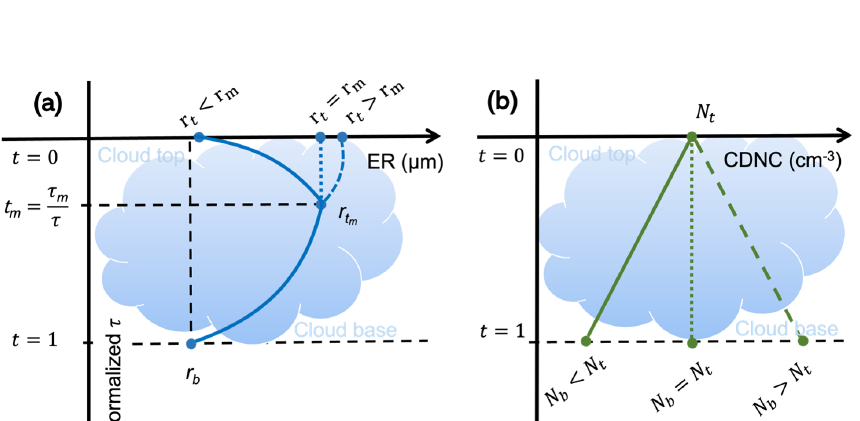
), and bottom ( τ = τ, t = 1) of the ER τ